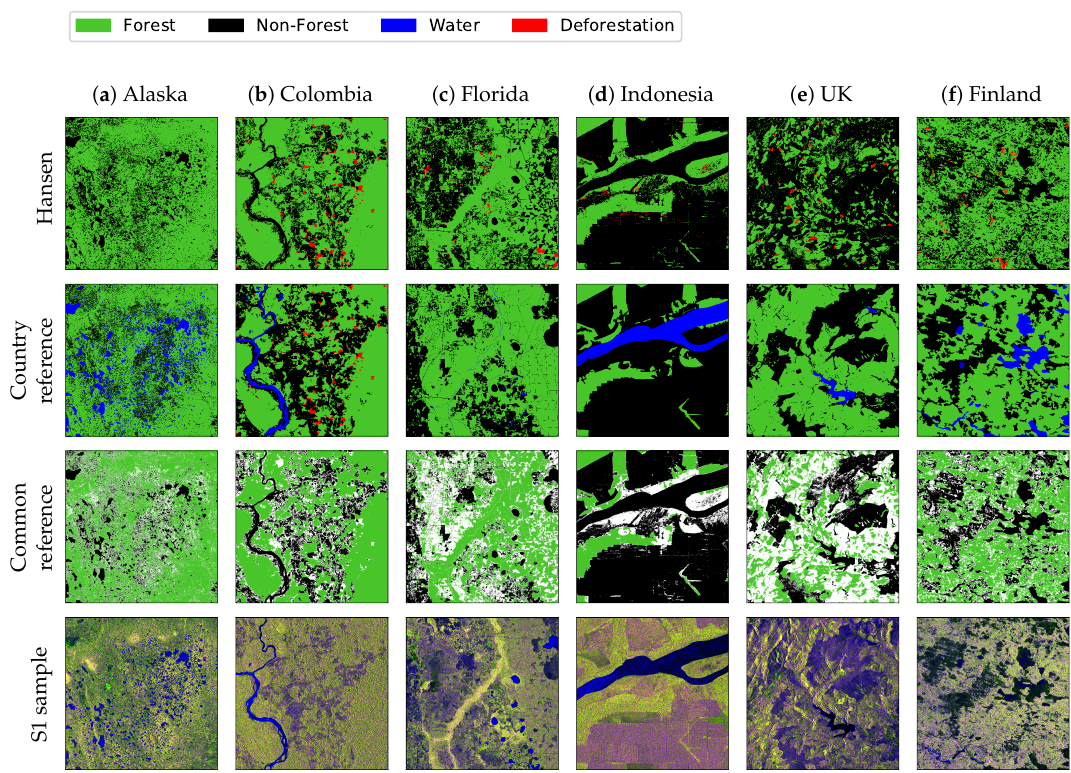
Figure 3. This figure shows the reference data for each of the six study sites, as well as sample Sentinel-1 images. Forested areas are shown in green, non-forest in black, deforestation in red, and water in blue. Areas of disagreement between the two references are left white in the third row. The Sentinel-1 images show the co-polarized (VV) backscatter intensity in the red channel, cross-polarized (VH) backscatter intensity in the green channel, and their ratio in the blue channel.